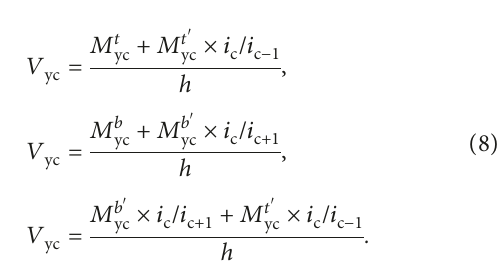
Figure 10: Method of elastic bending moment at the column